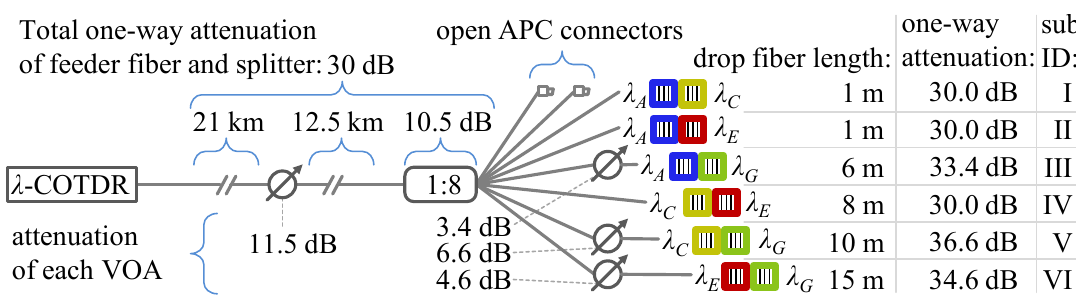
Figure 2. Schematic drawing of the passive optical network (PON)